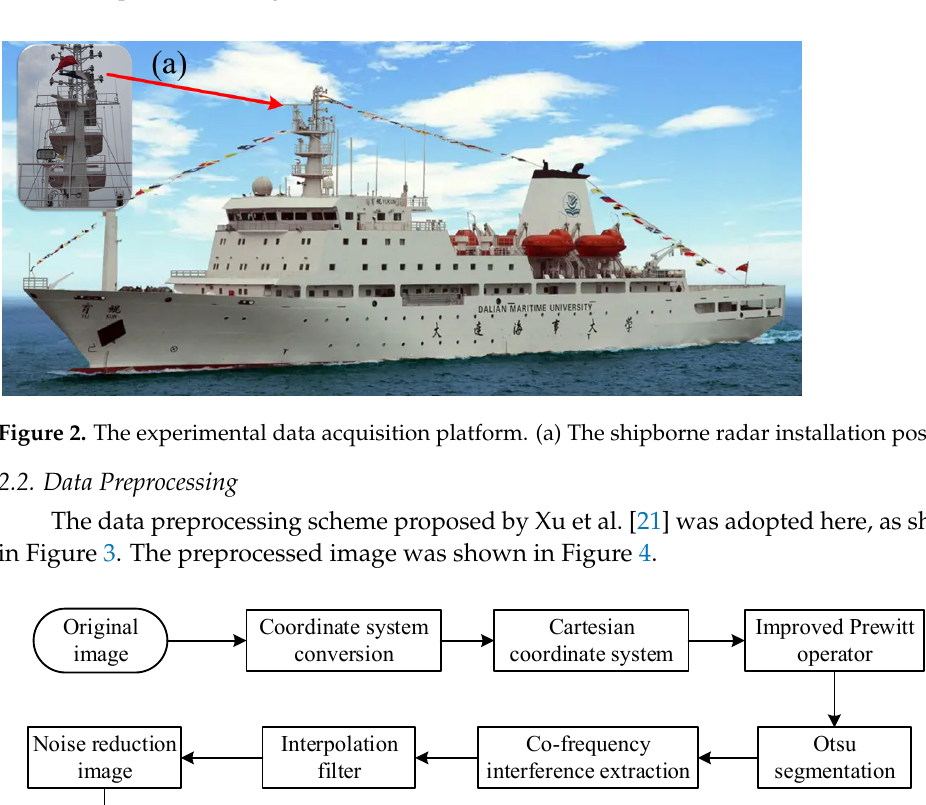
Figure 1. Experimental image.